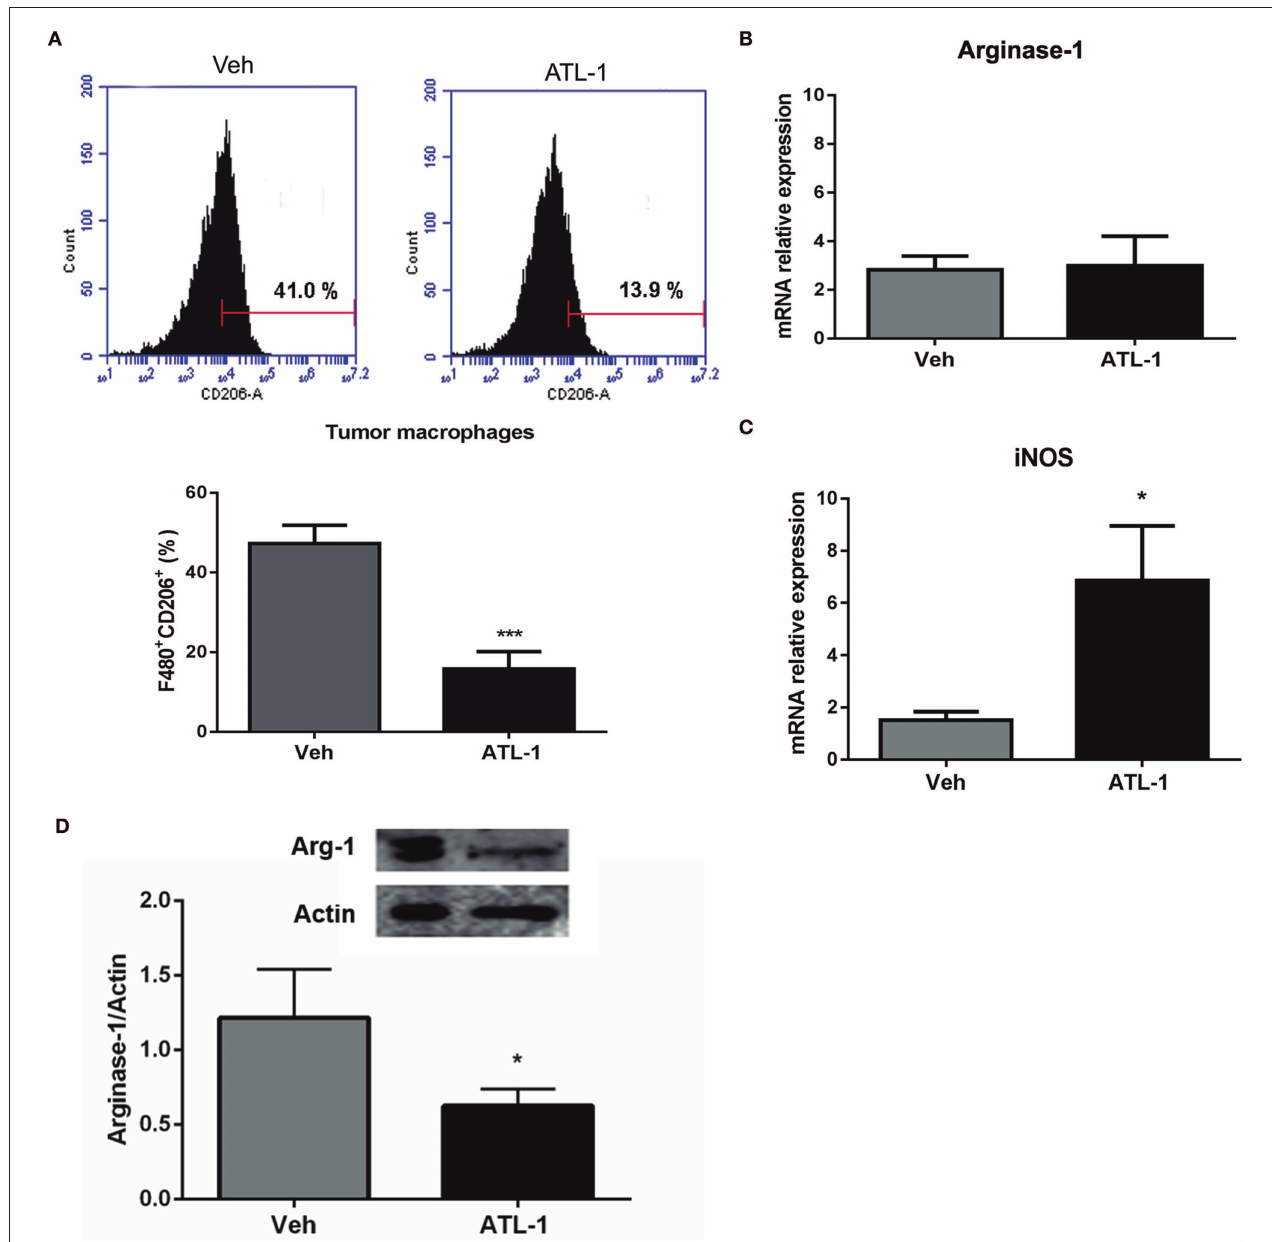
FIGURE 6 | ATL-1 treatment decreases M2 markers and increases M1 markers expression of TAMs in vivo . C 57/BL6 mice were inoculated with B16/F10 tumor cells. After 14 days, ATL-1 (1 µ g/animal) or vehicle (20 µ L ethanol) was administered i.v. After additional 7 days, animals were sacrificed, the tumors were dissected, and TAMs isolated for further analysis by flow cytometry, western blotting and RTqPCR. (A) F480 + / CD206 + cells ( n = 9); (B) Arginase-1 gene expression ( n = 6); (C) iNOS gene expression ( n = 6) and (D) arginase-1 protein expression ( n = 4). Gene expression is relative to the expression on 14th day. GAPDH or actin were used as housekeeping genes. Data are expressed as mean ± SEM. * p < 0.05; *** p < 0.001 by unpaired t